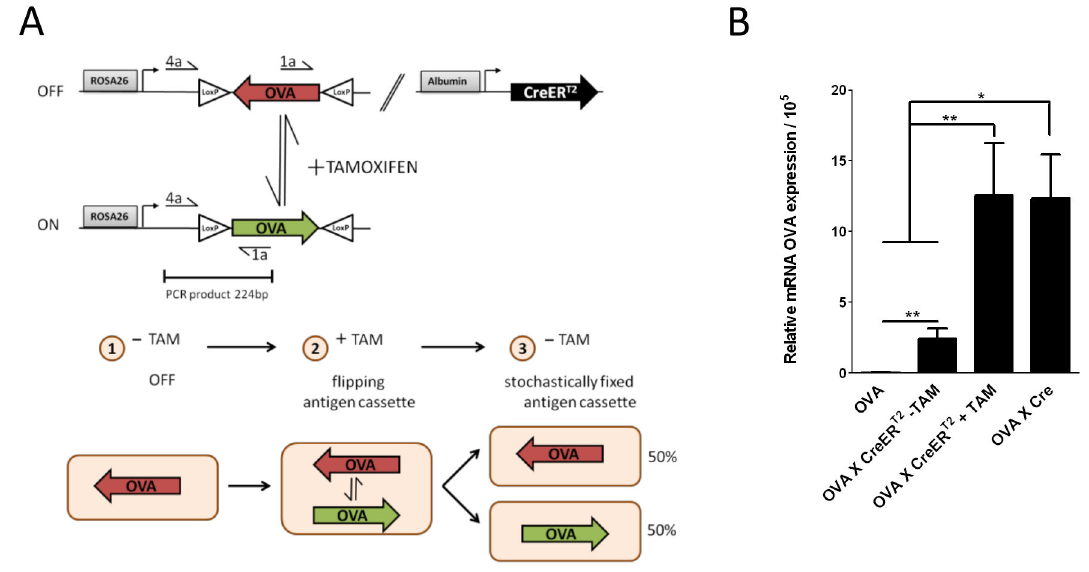
Figure 1. Schematic presentation of antigen induction and its expression levels in the mouse models. A . Schematic presentation of the antigen expression system in the mouse models. The OVA cassette is integrated in antisense orientation (OFF- state ‘1’, red) in the ROSA26 locus. The cassette is activated through an Albumin driven expression of CreER T2 in hepatocytes by a single application of TAM. Upon binding of TAM, the CreER T2 fusion protein translocates to the nucleus and can invert the OVA cassette (ON-state, green). In the presence of TAM, CreER T2 continuously flips the OVA cassette and the antigen is stochastically ‘ON’ or ‘OFF’ (‘2’, see also 16). Upon TAM clearance the recombination status becomes fixed (‘3’). Assuming that the activated Cre recombinase is active in all hepatocytes, 50% of cells carry the cassette in the ON-state. The binding sites of primers 1a and 4a used to amplify the OVA cassette in the ON-state are indicated. B . OVA mRNA expression levels in the liver of OVA_X_CreER T2 mice. OVA_X_CreER T2 were treated with a single dose of TAM. 9 days later, the liver was isolated and RNA was subjected to qRT- PCR using the indicated primers. After TAM clearance 50% of all hepatocytes remain in ON-state. The mRNA levels in the non- treated OVA_X_CreER T2 mice are 5 fold lower than those from the induced state or the standard. This corresponds to approximately 10% of hepatocytes that express the OVA antigen. OVA_X_Cre mice were used as a standard. Due to the constitutive Cre activity in these mice 50% of all cassettes are supposed to be in the ON-state. The OVA expression levels are related to albumin. The bars reflect samples from 4–8 animals that were individually